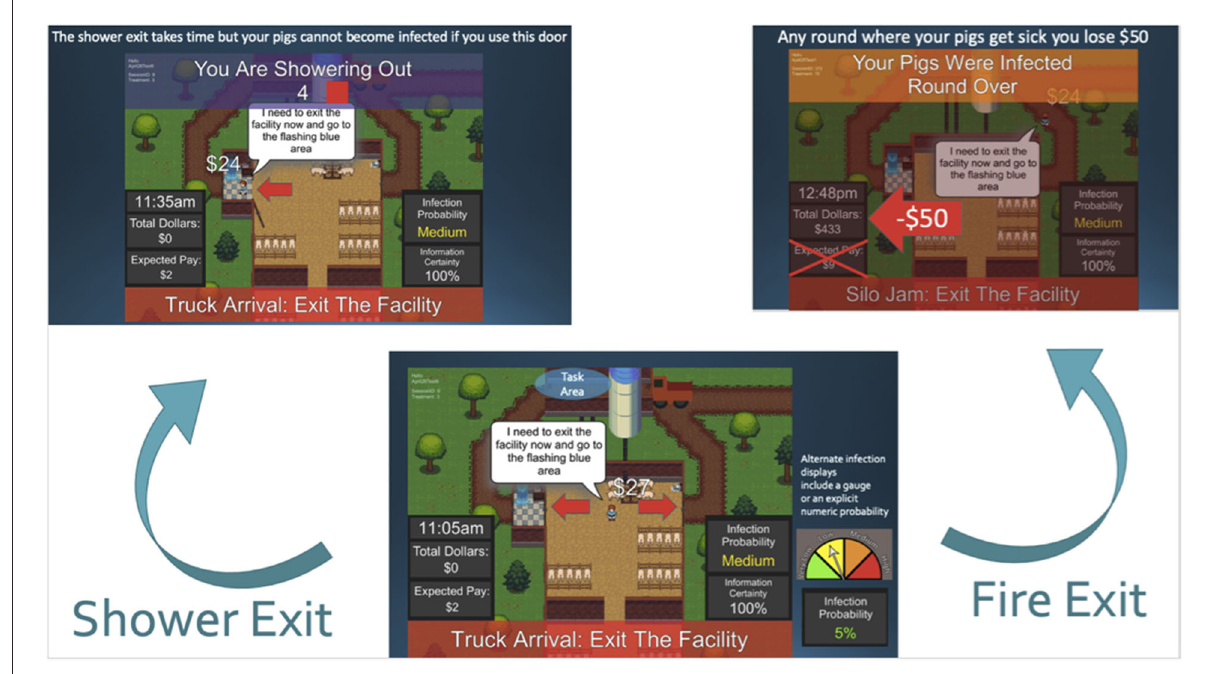
FIGURE1 Screenshot of the compliance game decision mechanism. Participants can choose to comply with a biosecurity shower protocol carrying an associated time cost, or bypass via the emergency exit which can subject the facility to infection.